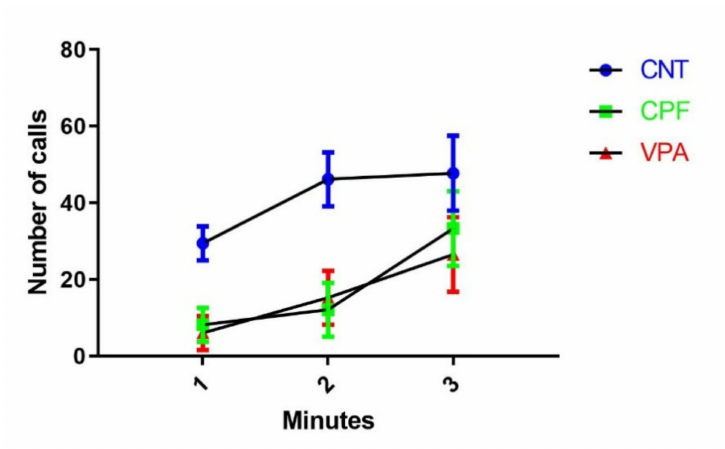
Figure A1. Evolution in the number of calls (CNT n = 14; CPF n = 14; VPA n =